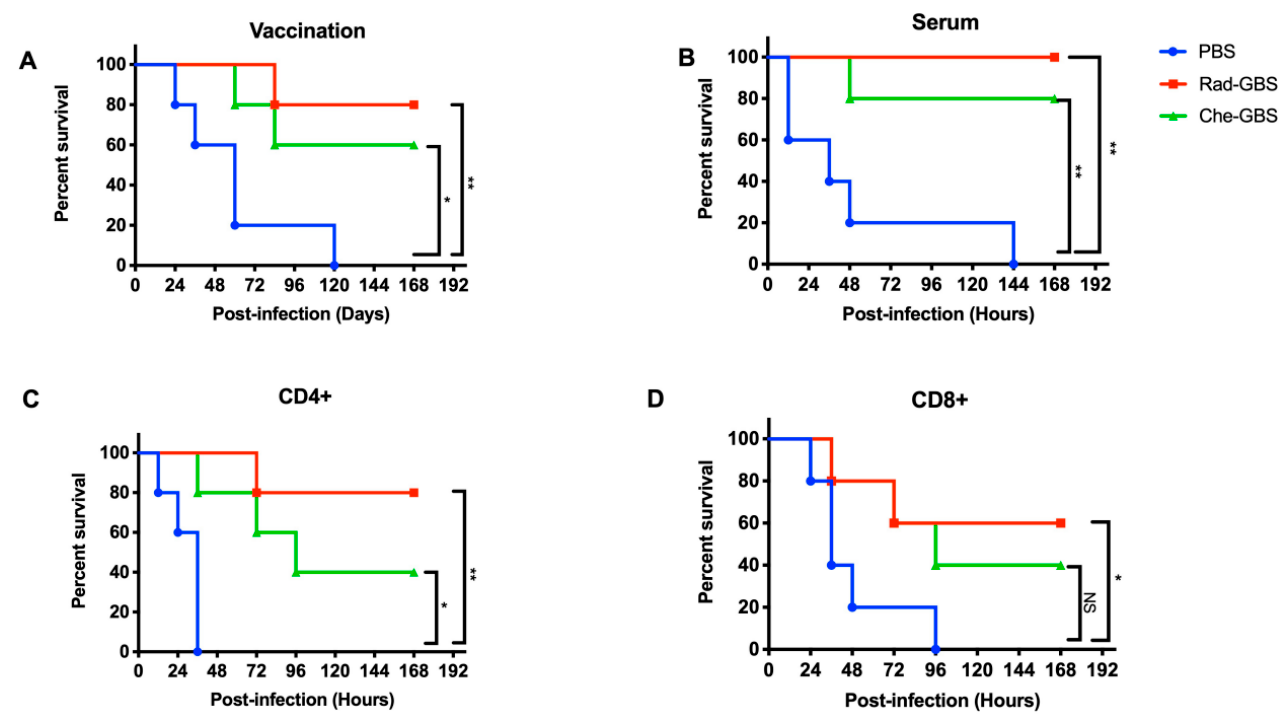
Figure 6. Evaluation of Rad-GBS-induced protection and increased survival in response to CNCTC 10/84 challenge. Mice ( n = 5) were intramuscularly vaccinated with 10 8 CFU of Rad-GBS or Che-GBS as described above. ( A ) All mice were intravenously challenged with 5 × 10 8 CFU of CNCTC 10/84 GBS, and survival in each group was recorded daily for one week. To investigate the protection origins from immune responses, adoptive transfers of vaccinated mouse serum or CD4 + or CD8 + T cells with GBS challenge was used. ( B ) Serum (300 µL), ( C ) Splenic CD4 + T cells, or ( D ) CD8 + T cells from alum or vaccinated mice was inoculated intraperitoneally into naïve C57BL/6 mice ( n = 5). At 24 h following transfer, mice were also challenged intravenously with CNCTC 10/84 GBS. Mouse survival was monitored for 7 days. The survival of mice was determined using Kaplan–Meier survival analysis, and the significance of the difference was analyzed using a log-rank test. ** stands for p < 0.01 and * stands for p < 0.05 and NS for not significant.